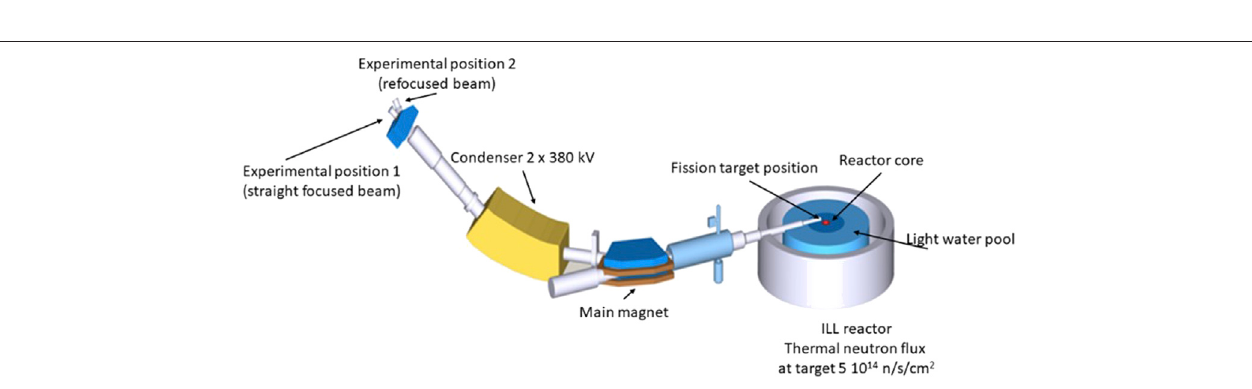
FIGURE 5 | Schematic of the LOHENGRIN spectrometer